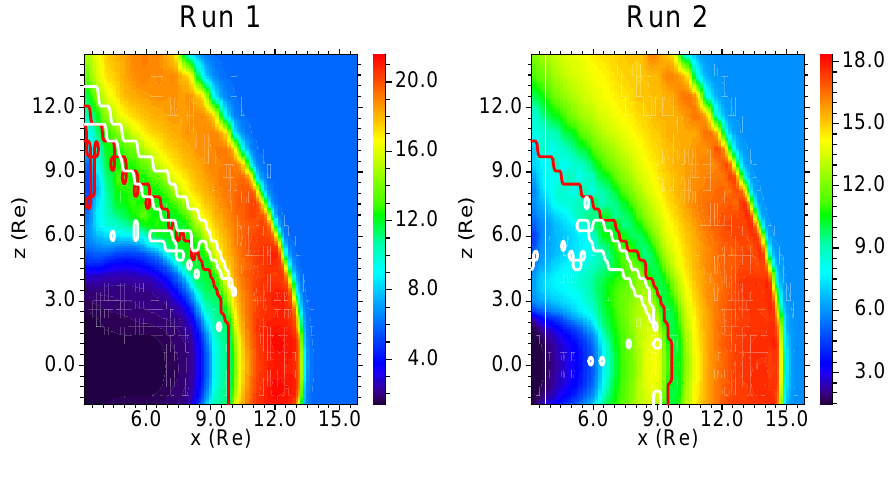
Fig. 11. Comparison between the slow mode fronts in the GSE y=0 plane for Run 1 and Run 2. The open-closed magnetic field boundary is shown as a red zigzag curve and the slow mode fronts are shown as closed white zigzag curves (only the segments of the white curves where flow moves into the closed regions should be identified as the slow mode fronts) in each of the